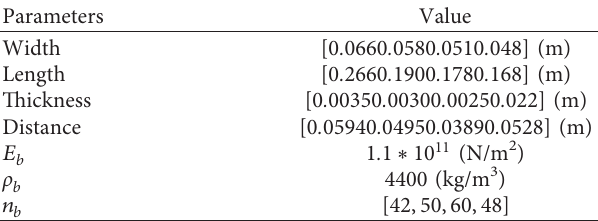
Table 3: The parameters of the blade.